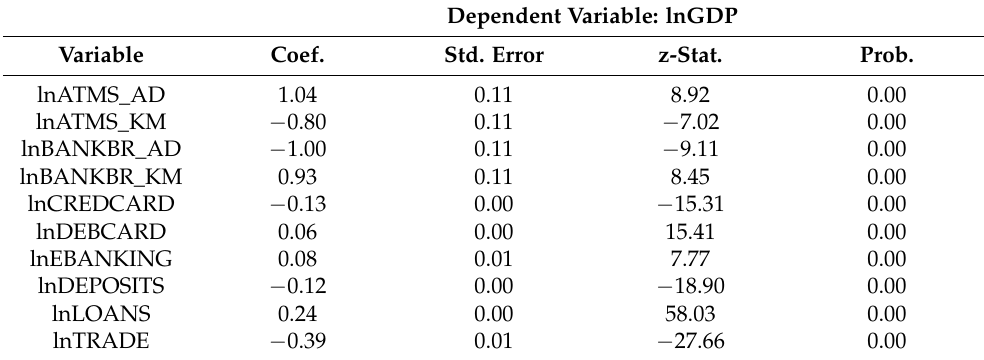
Table 7. Fully Modified Ordinary Least Squares (FMOLS) estimation